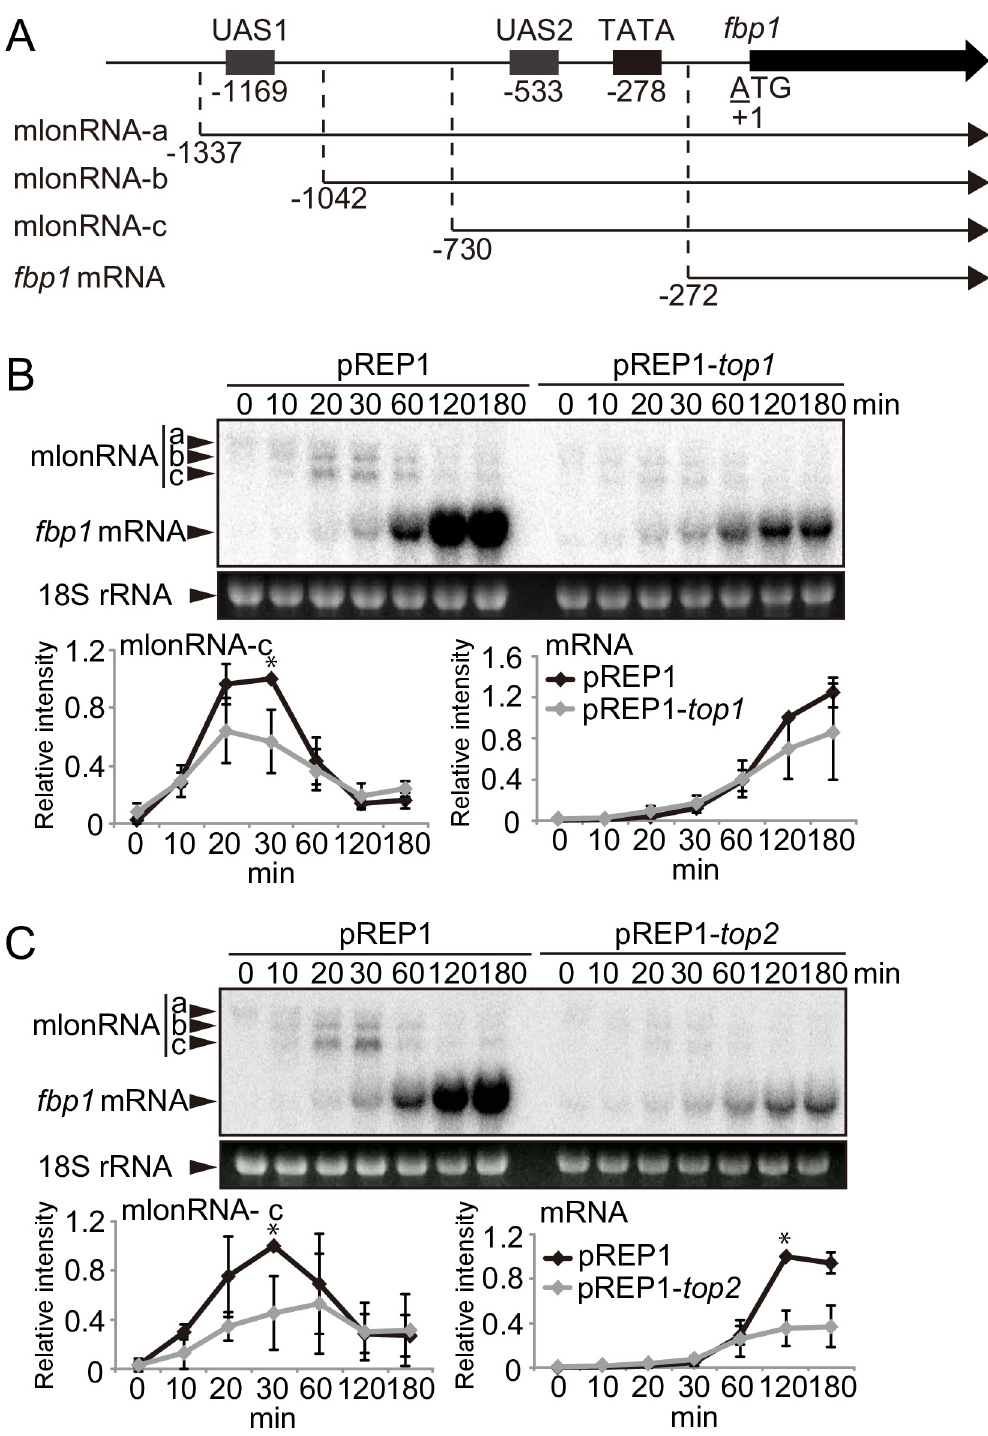
Fig 2. Aberrant fbp1 transcription by topoisomerase overexpression. (A) Schematic drawing of the region upstream from fbp1 containing upstream activation sites 1 and 2 (UAS 1 and UAS2). The mlonRNAs transcribed across the fbp1 upstream region and fbp1 mRNA are presented. The numbers indicate the transcription initiation site of the fbp1 transcripts and the distances of UAS1, UAS2, and the TATA box from the first ATG of fbp1 ORF. (B, C) Transcription of fbp1 gene during the course of glucose starvation in control cells (carrying the vector [pREP1]), top1 -overexpressing cells (pREP1- top1 , B), and top2 -overexpressing cells (pREP1- top2 , C). The cells were cultured for 16 h in MM containing 6% glucose (glucose +)